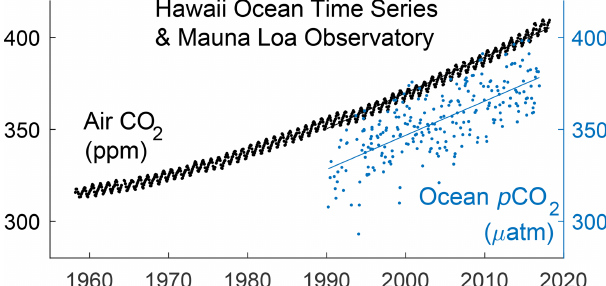
Figure 6. Atmospheric CO 2 (black dots) measured at the Mauna Loa Observatory in Hawaii beginning in 1958 and surface ocean p CO 2 data (blue dots) from the Hawaii Ocean Time Series (HOT) station (see Fig. 3 for site location). Black and blue lines indicate linear trends after 1990. Atmospheric CO 2 in- creased by 1 . 86 ± 0 . 11ppmyr − 1 . Surface ocean p CO 2 increased